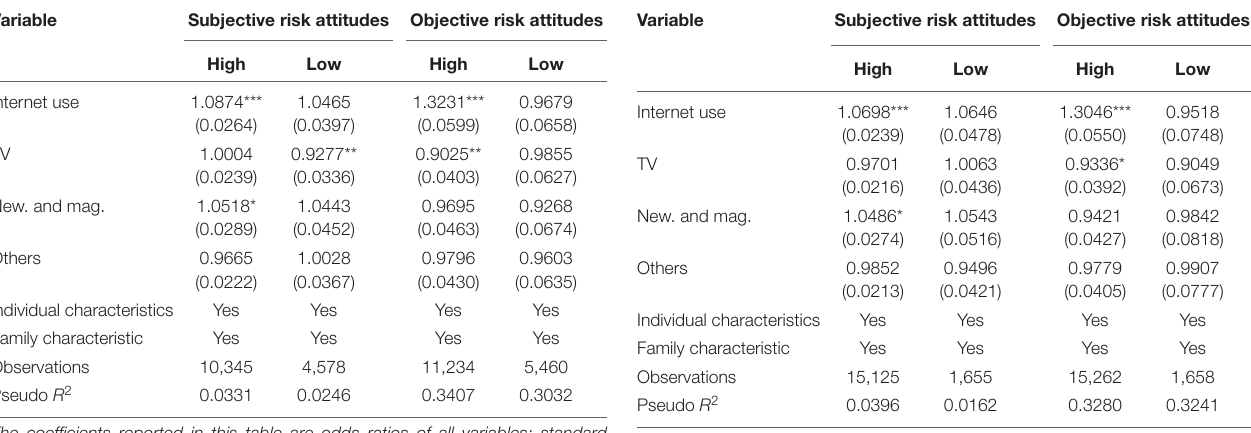
TABLE 5 | Grouped by the using frequency for socializing.